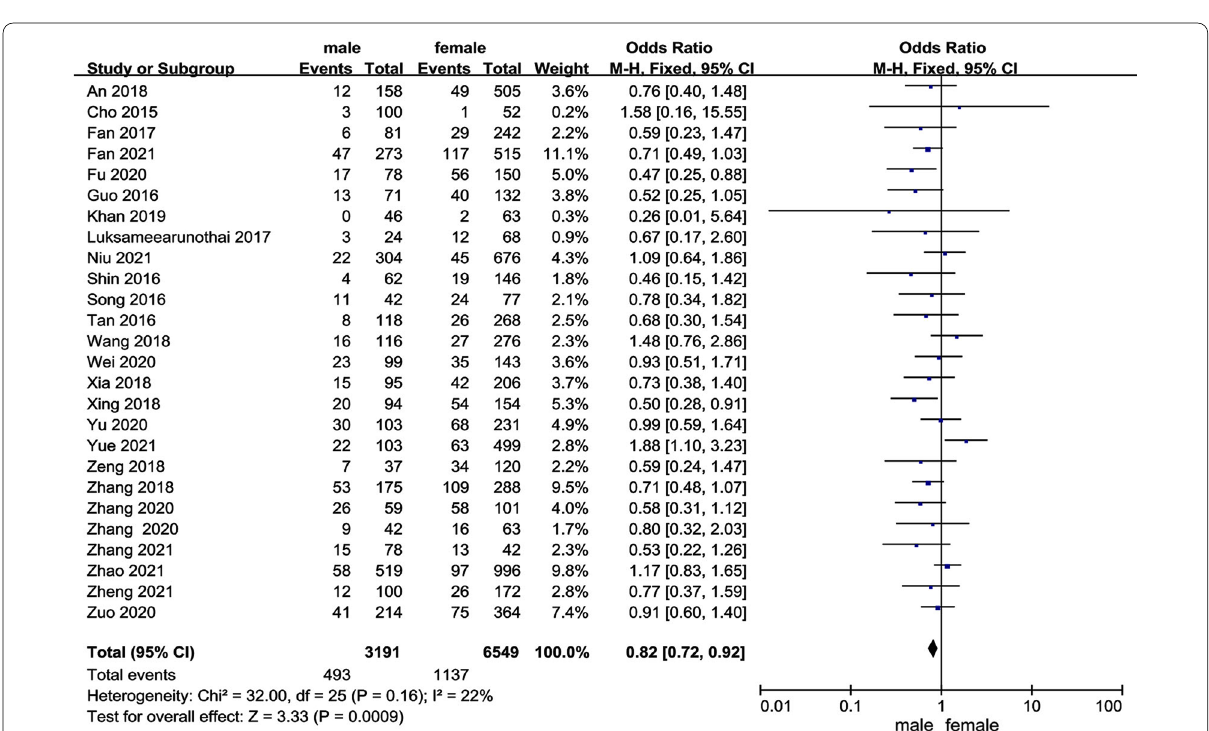
Fig. 3 Forest plot showing sex in 2 groups. CI confidence interval, df degrees of freedom, M-H